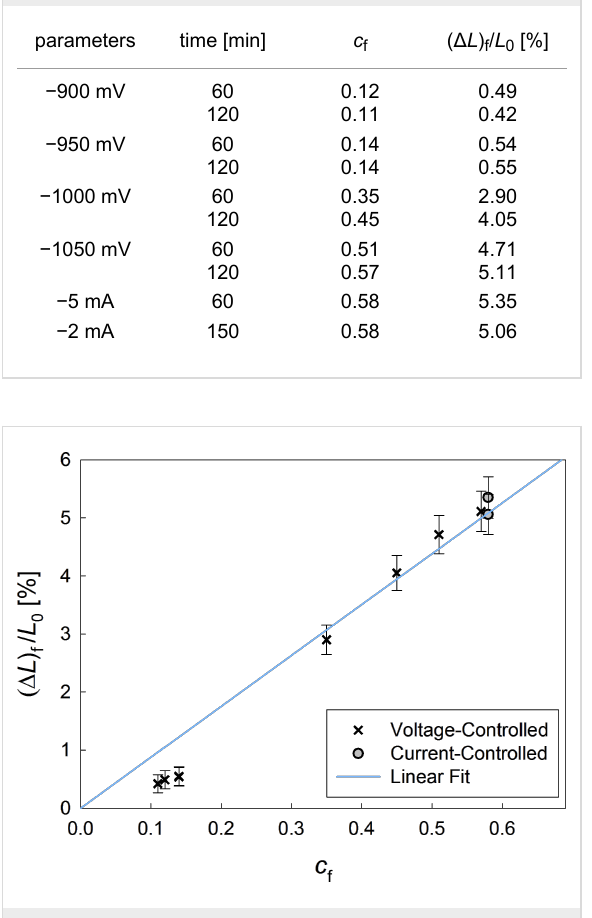
Figure 3: Thickness variations ( Δ L ) f / L 0 of np-Pd upon loading experi- ments up to different final hydrogen concentrations characterized by the H/Pd atomic ratio c f (see Table